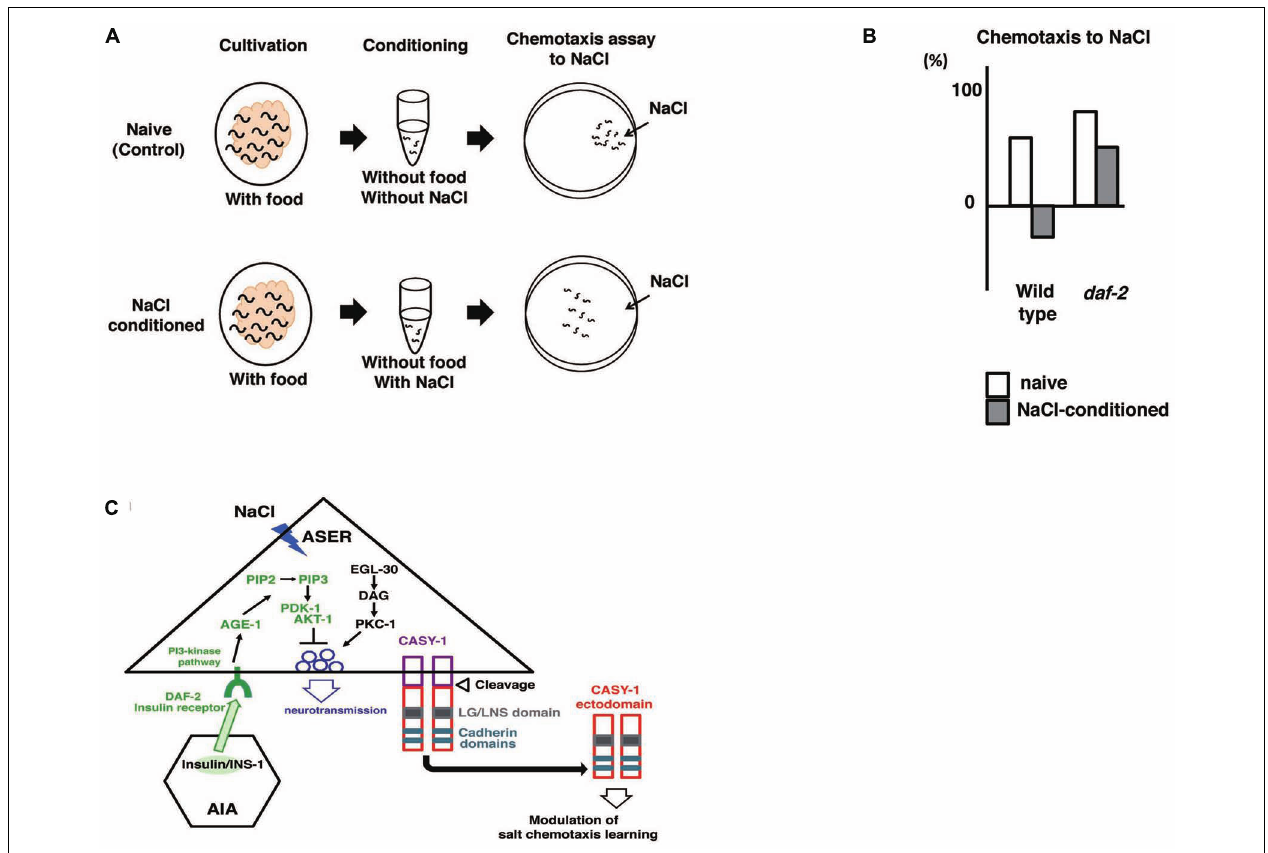
FIGURE 7 |Associative learning between salt and food (Saeki etal., 2001; Tomioka etal., 2006; Ikeda etal., 2008). (A) Scheme for experiments. (B) The daf-2 mutants are defective in salt learning. (C) Proposed model for the regulation of salt learning. Insulin-like peptide INS-1 is secreted from AIA interneurons and the insulin-like signaling pathway is activated in the ASER neuron through the insulin receptor DAF-2. DAF-2 activates PI3 kinase AGE-1 that converts PIP2 to PIP3, which leads to activation of the downstream signal components